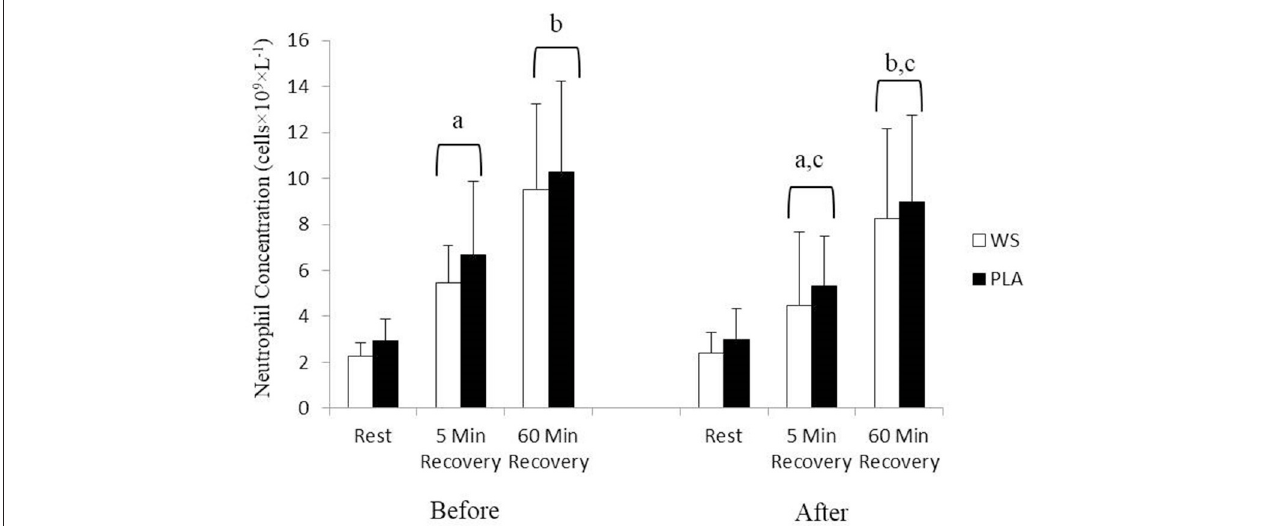
FIGURE 2 | Neutrophil concentration at rest, 5 and 60min after exercise before and after training for the whey supplement (WS) and placebo (PLA) groups. Values are means ± SD. a, significantly different from rest, P < 0.05; b, significantly different from rest and 5min after exercise, P < 0.05; c, significantly lower at 5 and 60min of recovery after training, P < 0.05.